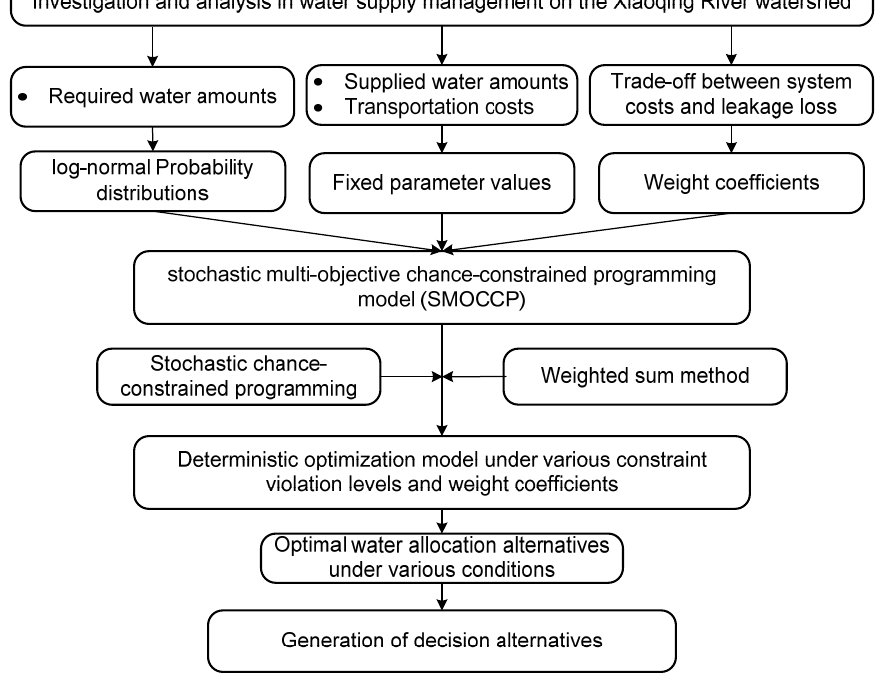
Figure 1. Formulation and solution framework of the stochastic multi-objective chance-constrained programming model (SMOCCP) model.